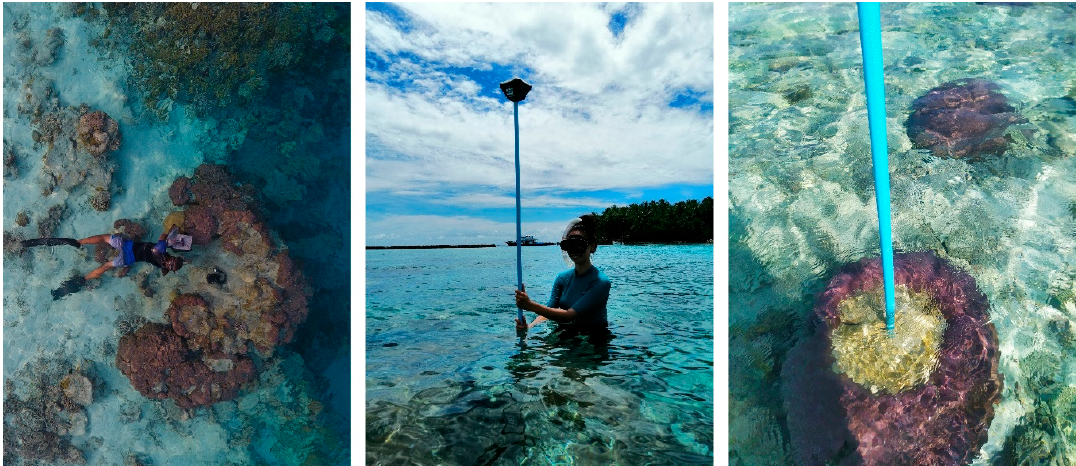
Figure 3. Identification of suitable ground control point features over easily recognizable structures from drone